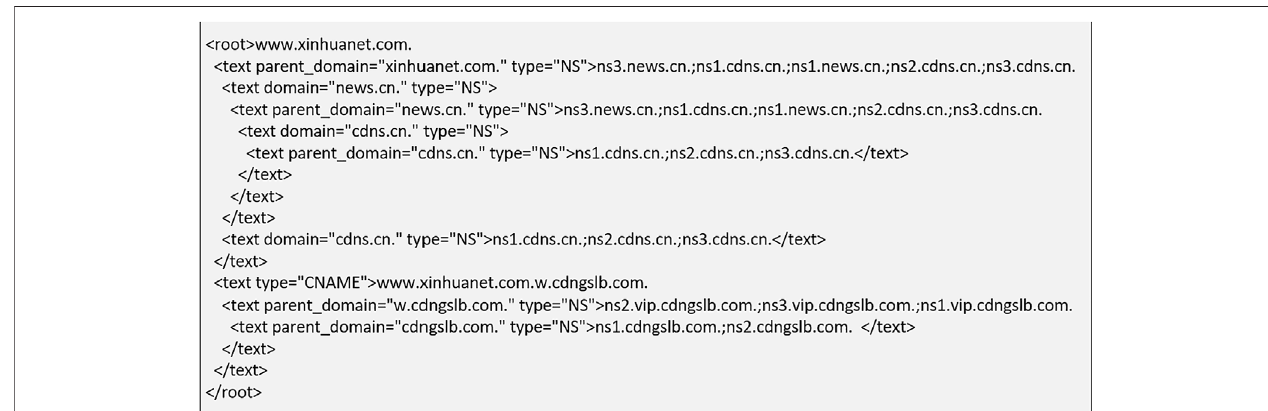
FIGURE 2 | A XML format for resolution path data of a domain